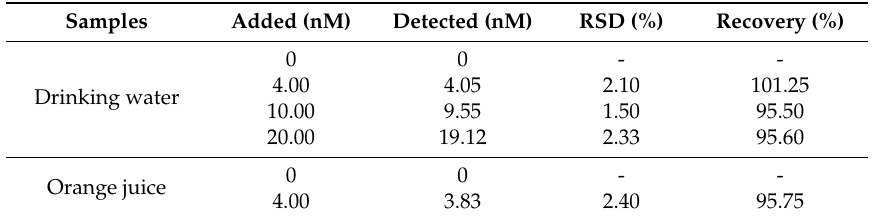
Figure 4. UV-Vis responses of sensor to various concentrations of MC-LR. ( A ) photographs of MC-LR solutions of various concentrations (a–k) and colorimetric spectra of sensor for various MC-LR concentrations (nM): (a) 0, (b) 0.05, (c) 1.0, (d) 2.0, (e) 3.0, (f) 4.0, (g) 5.0, (h) 10.0, (i) 15.0, (j) 20.0, (k) 25.0, (l) 30.0 and (m) 35.0; ( B ) corresponding calibration curve of absorbance values at 600 nm against MC-LR concentration. Table 1. MC-LR detection results obtained using proposed method ( n =